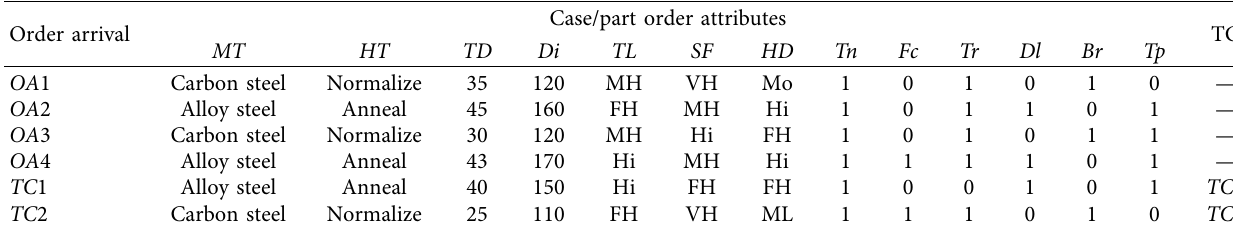
Table 5: Constructed case with their 13 case